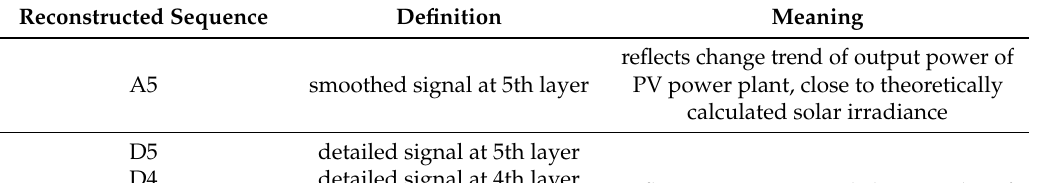
Table 3. Layers Definitions of WD.